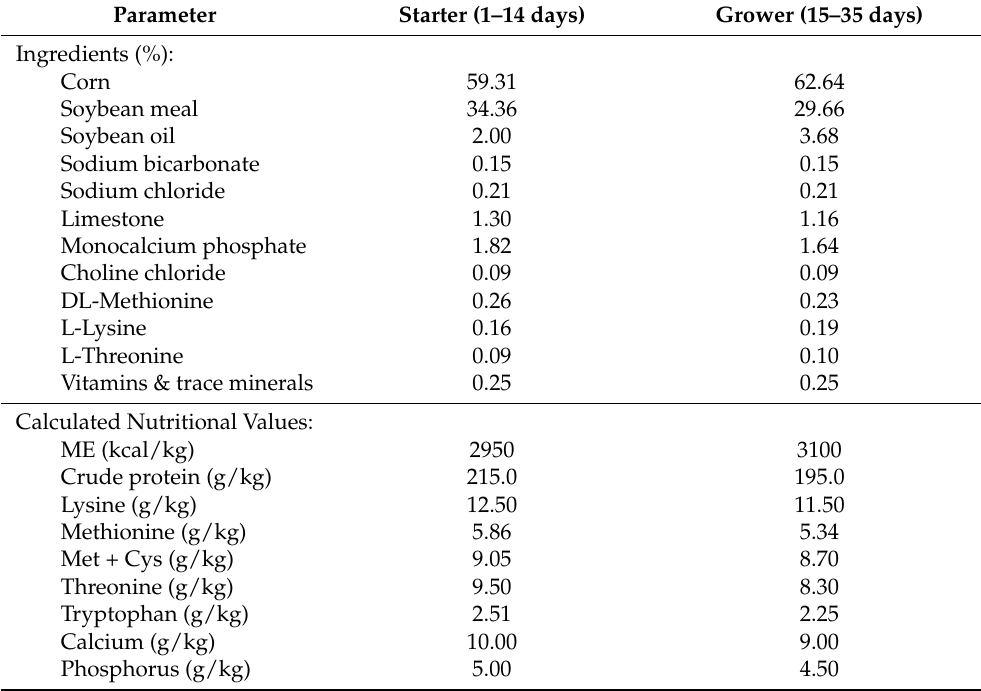
Table 1. Details of the basal diets used for the broiler performance